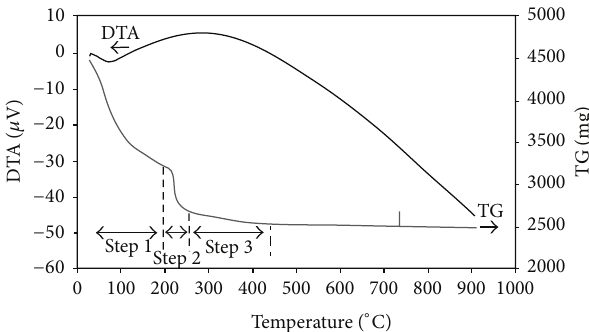
Figure 9: Particle size distribution of the polymeric titania sol.